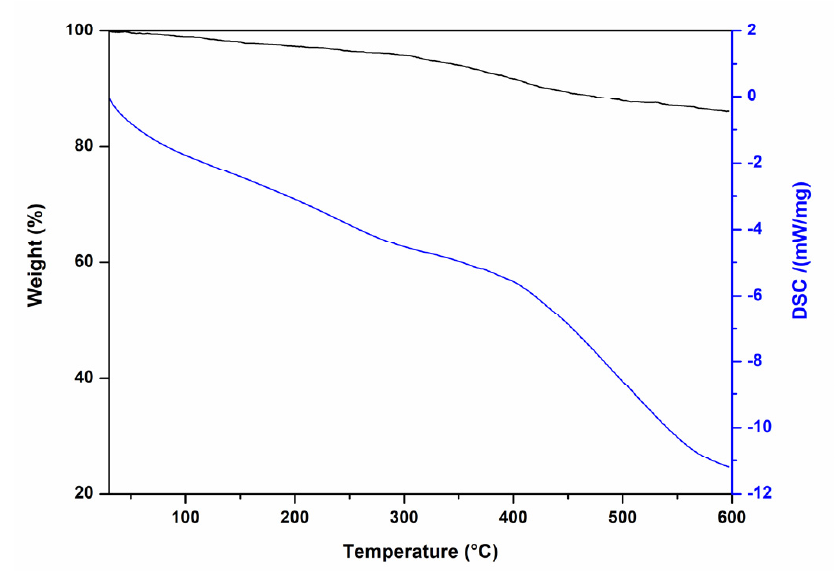
Figure 4. TG analysis of MCM-41@ILLaCl 4 catalyst.